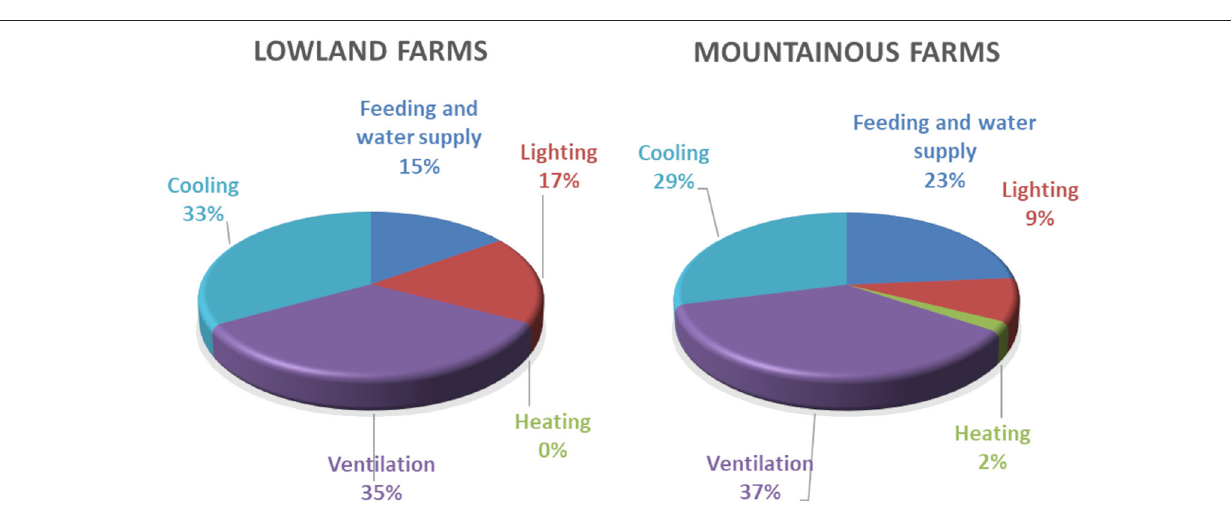
FIGURE 6 | Distribution of electrical energy consumption in lowland and mountainous